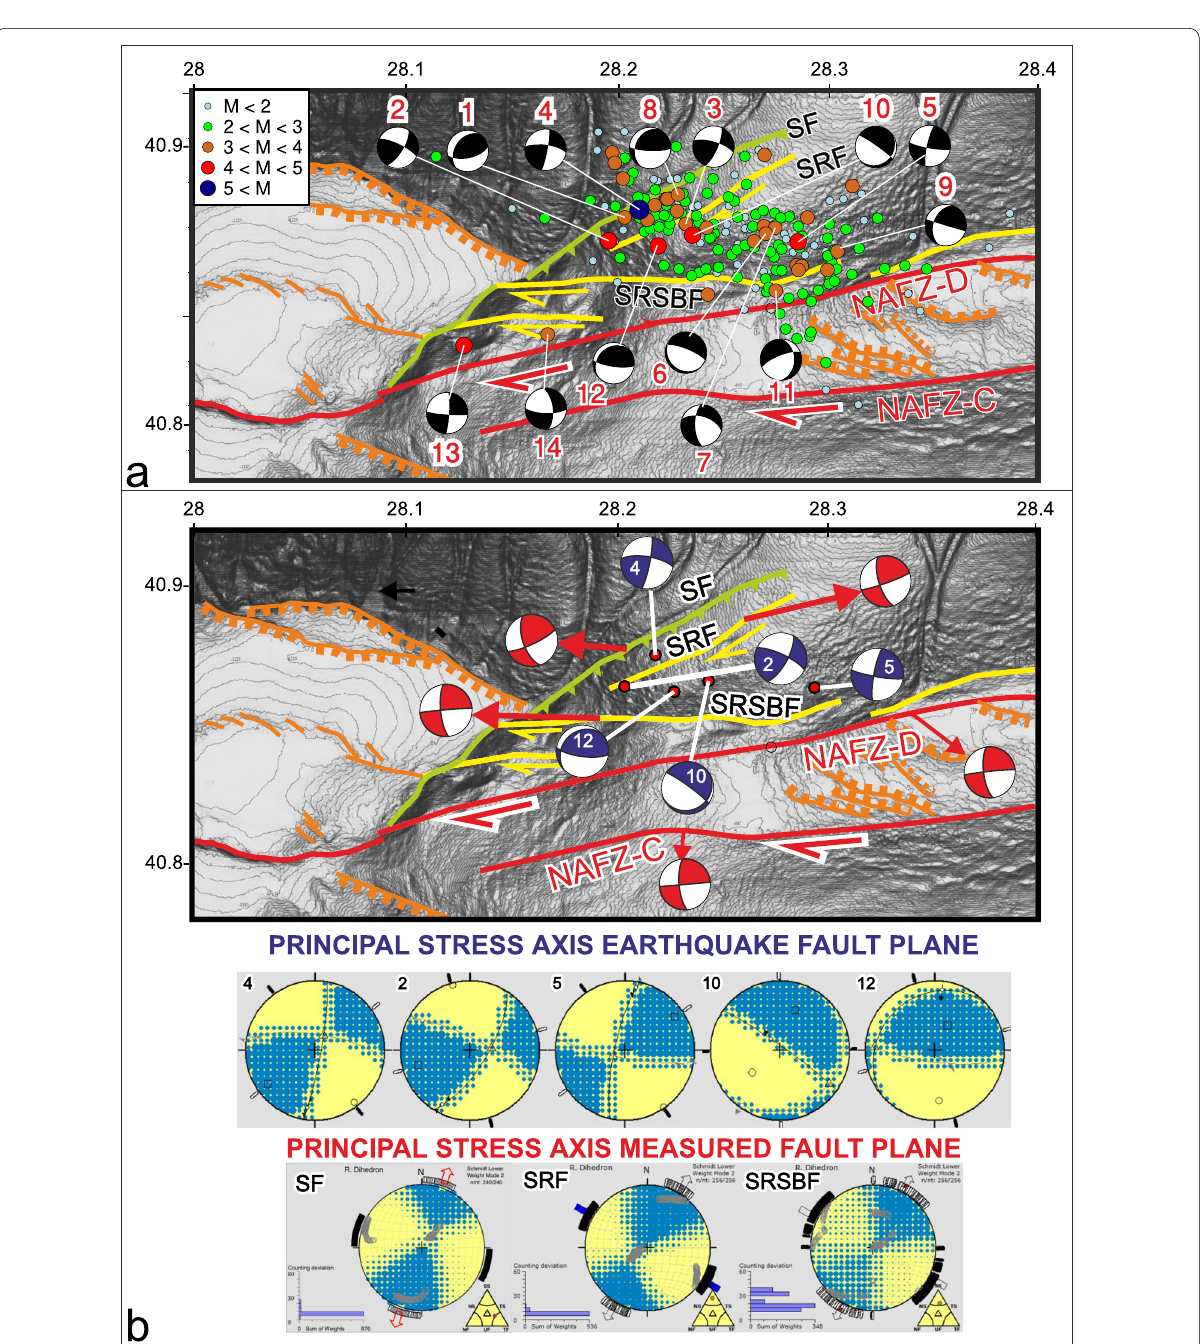
Fig. 5 a Distribution of the 2019 Silivri earthquakes. The numbers with source mechanism solutions are from Additional file 1: Table S1. Green-colored lines show dextral oblique thrust faults, yellow- and red-colored lines show dextral strike-slip, and orange-colored lines stand for normal faults. b Correlation of kinematic analysis of the source mechanism solution (in dark blue color) and fault planes (in red